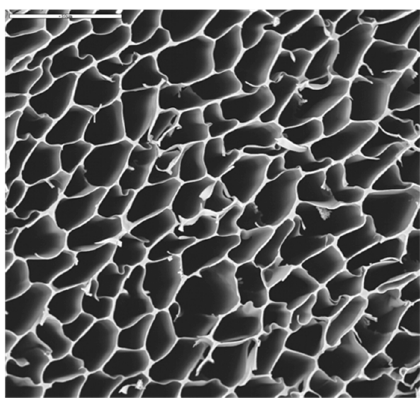
Figure 6. Scanning electron microscopy (SEM) micrograph of AgNPs ‐ CS crosslinked scaffold. Bar 50 μ m.